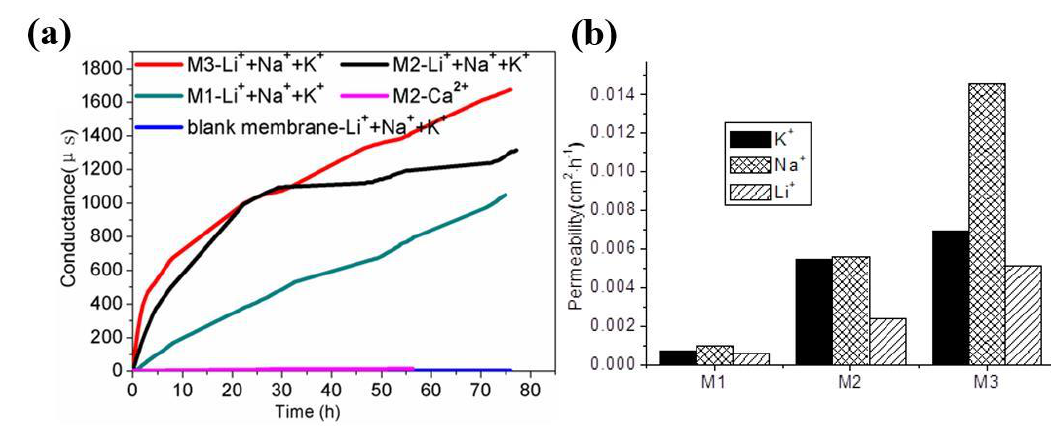
Figure 8. Figure 8. Electrical conductivity of Ca 2+ ( a ) and Mg 2+ ( b ) in blank membrane (M0) and organic– inorganic hybrid ion channel membranes (HM1–HM5) as a function of time.